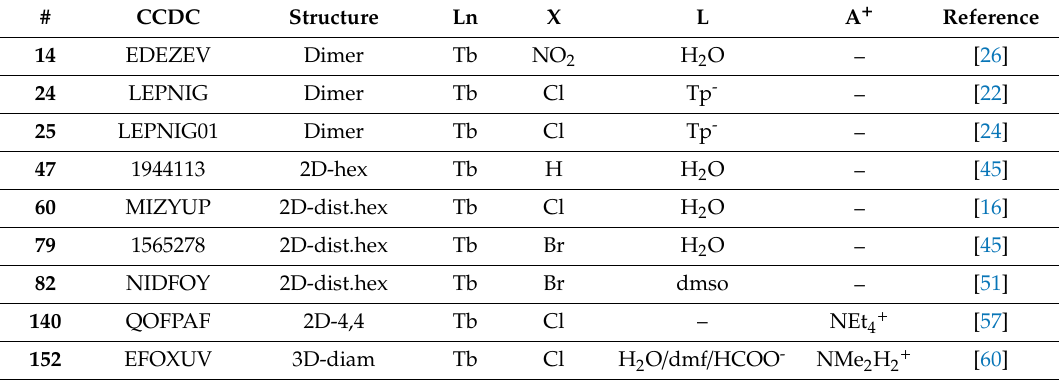
Table 21. Structurally characterized Tb(III) compounds with anilato ligands.